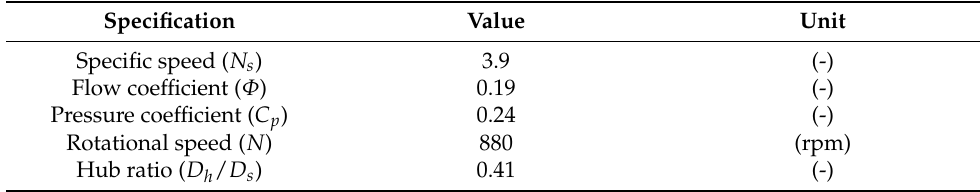
Table 1. Design specifications of the wall-mounted axial fan.